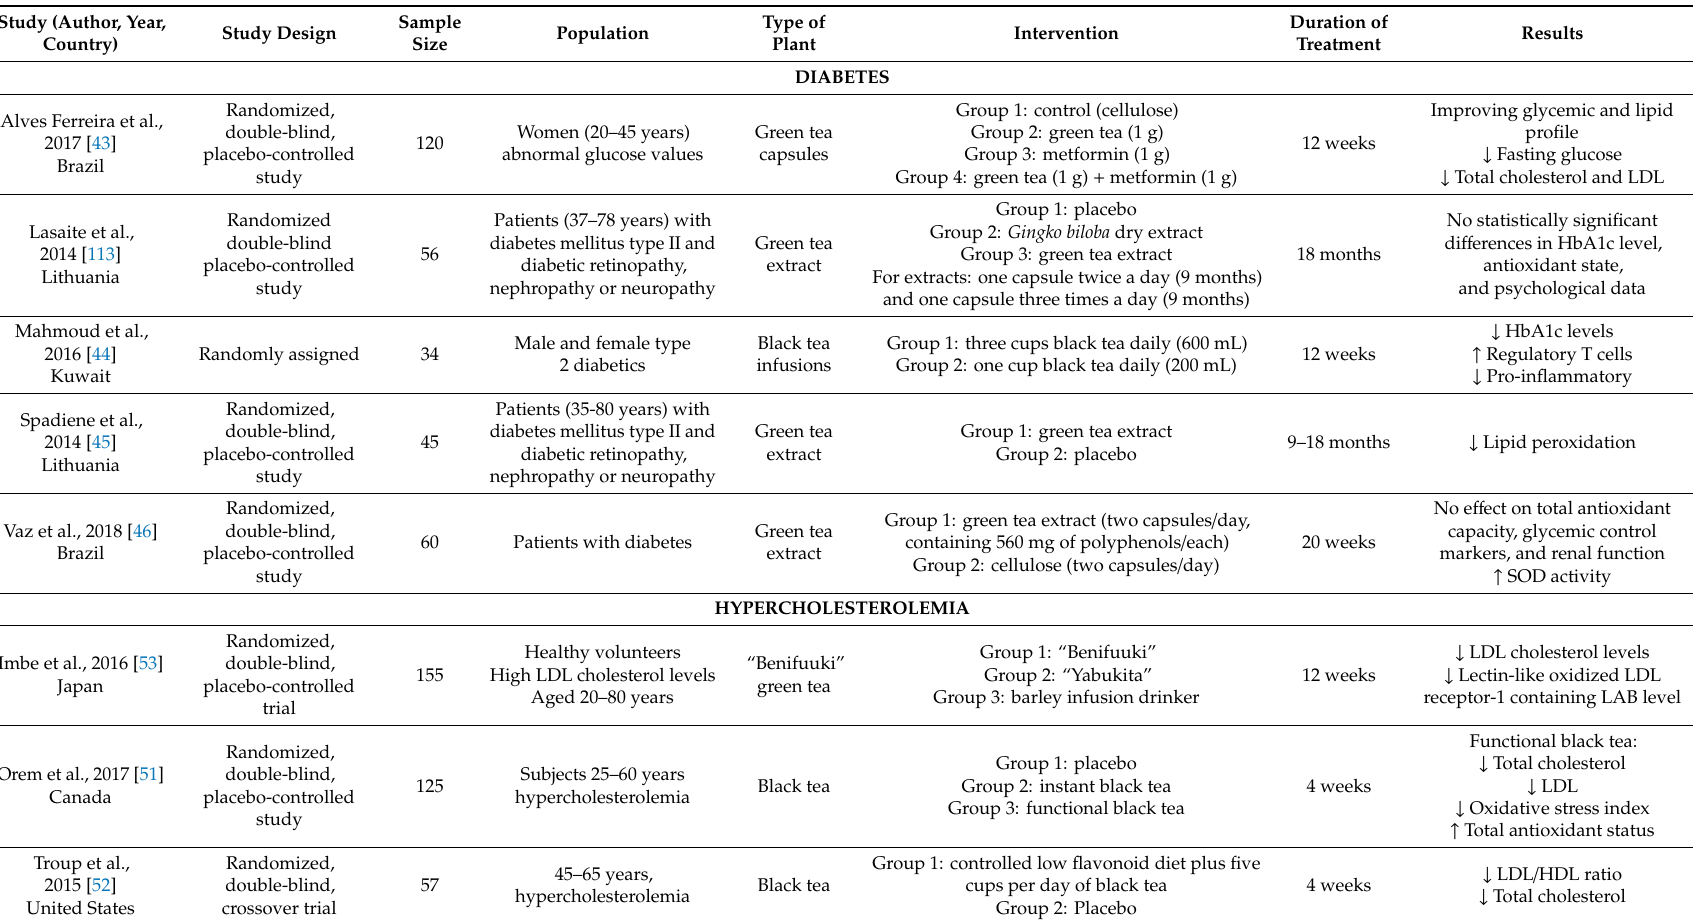
Table A3. Clinical trials for Camellia